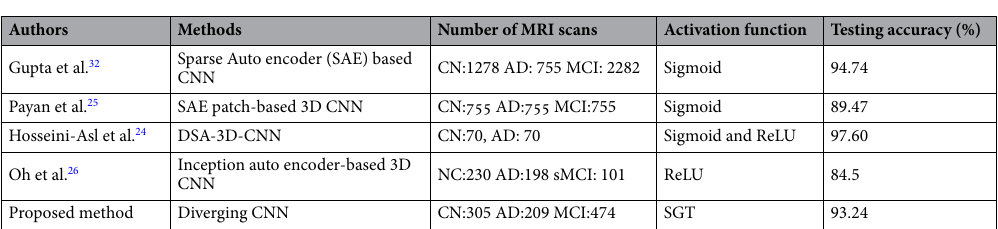
Table 4. Comparison with other works in MRI classification. Please note the difference in number of MRI